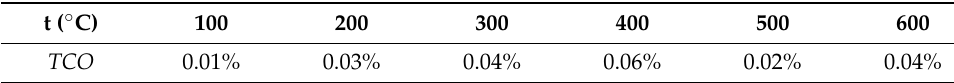
Table 4. Thermal zero offset drift coefficient (TCO) of the sensor.